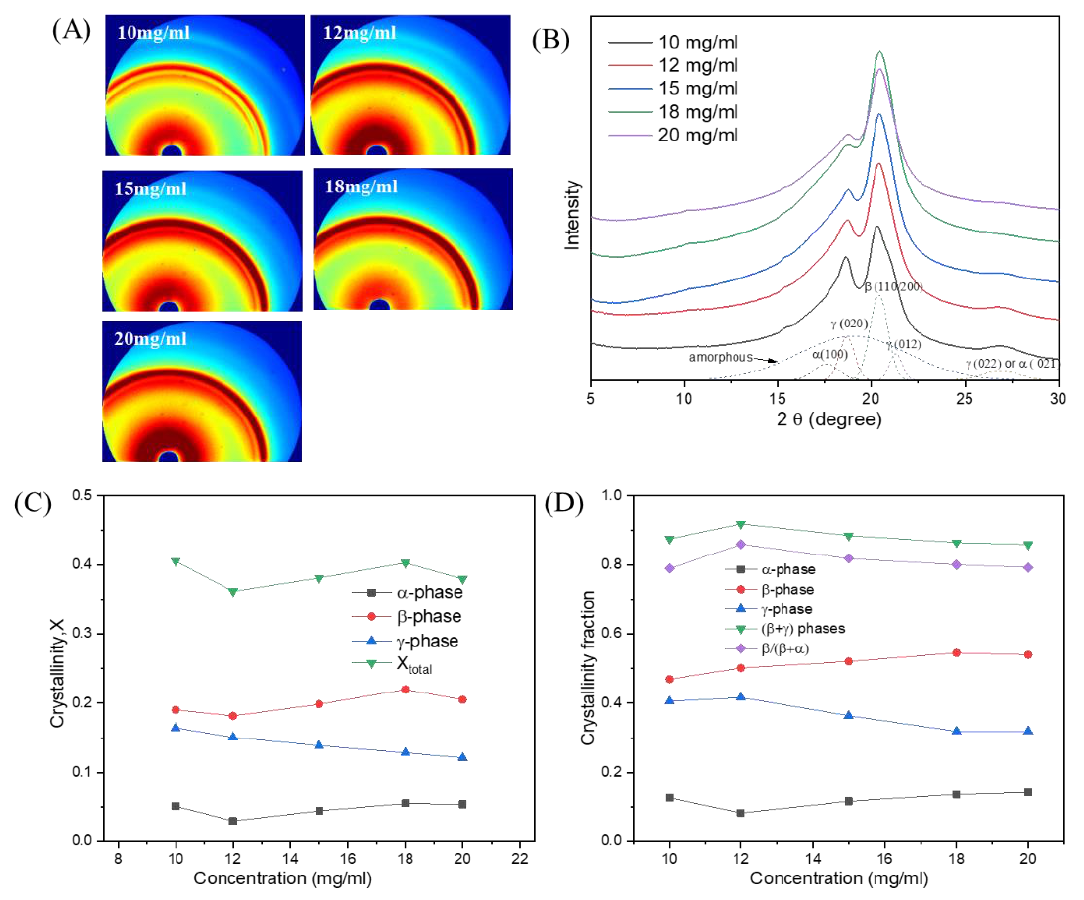
Figure 8. ( A ) 2D GIWAXS patterns of ultrasonic spray-coated PVDF films obtained by various concentrations. ( B ) 1D GIWAXS profiles of ultrasonic spray-coated PVDF films obtained by various concentrations. ( C ) Concentration-dependent crystallinity of various crystalline phases of ultrasonic spray-coated PVDF films. ( D ) Concentration-dependent crystallinity fractions of a certain crystalline phase in the crystallinity of ultrasonic spray-coated PVDF films.